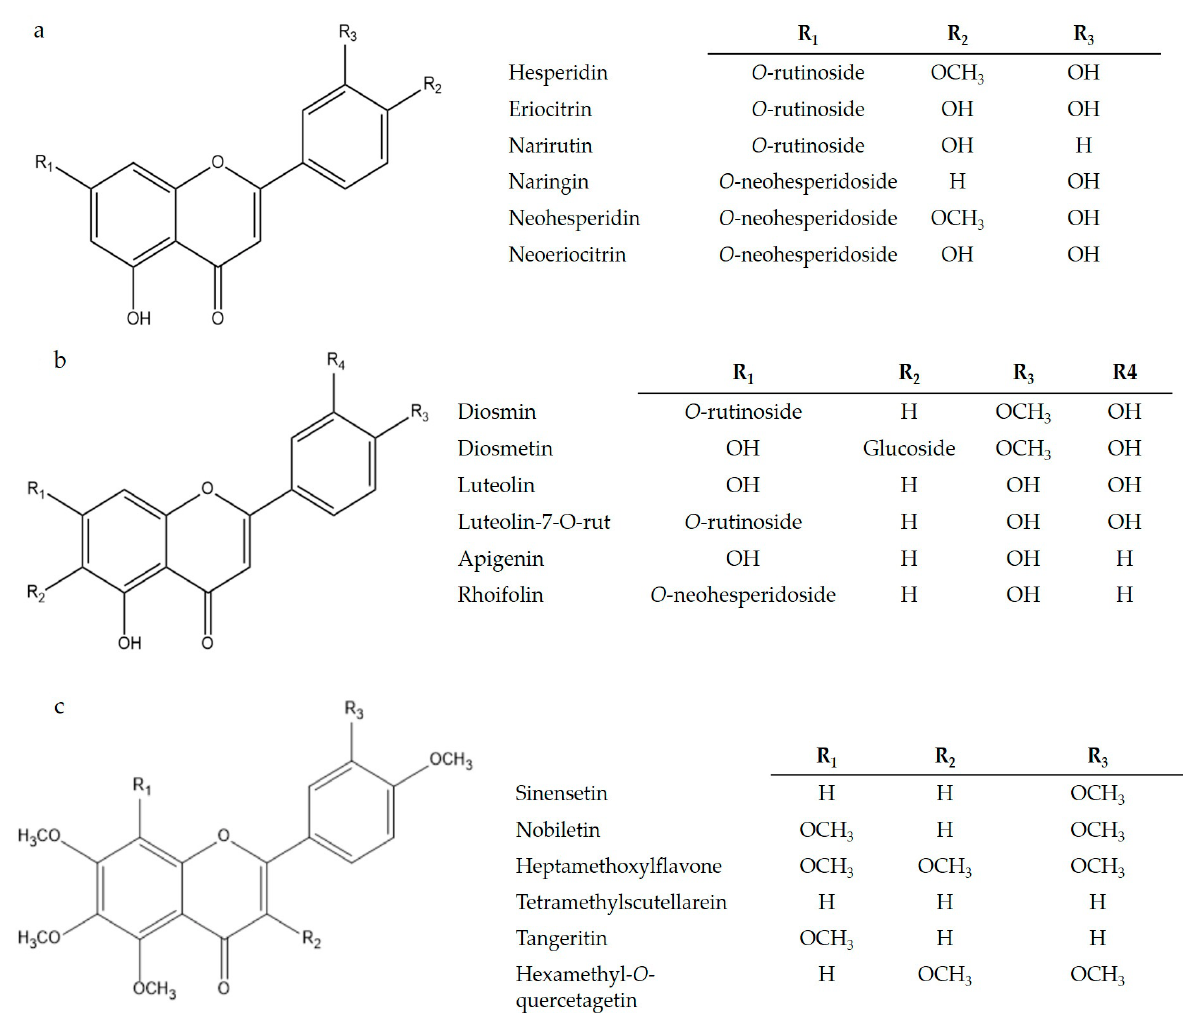
Figure 3. The main flavanones ( a ), flavones ( b ), and polymethoxylated flavones ( c ) found in citrus fruits. Source [51–55].